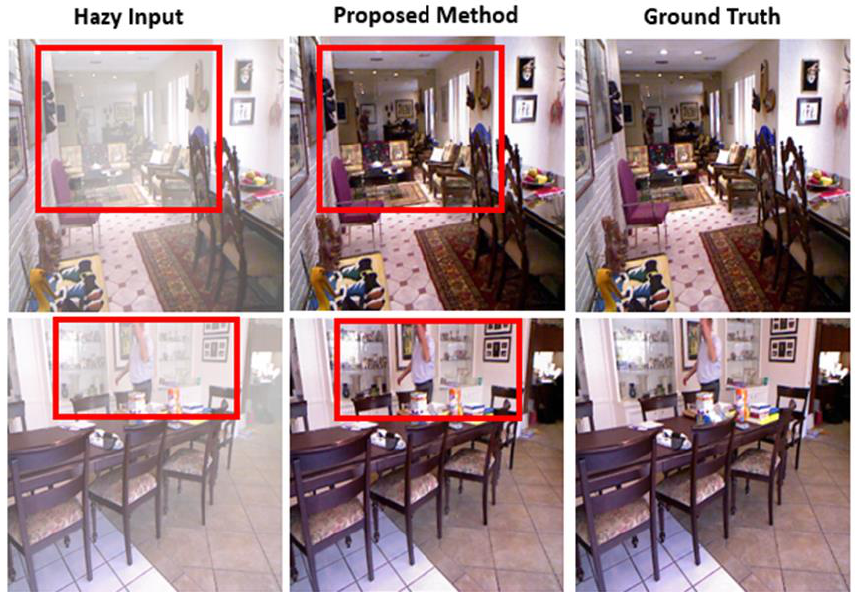
Figure 8. Comparison of dehazing results from RESIDE SOTS indoor testing dataset with ground truth.